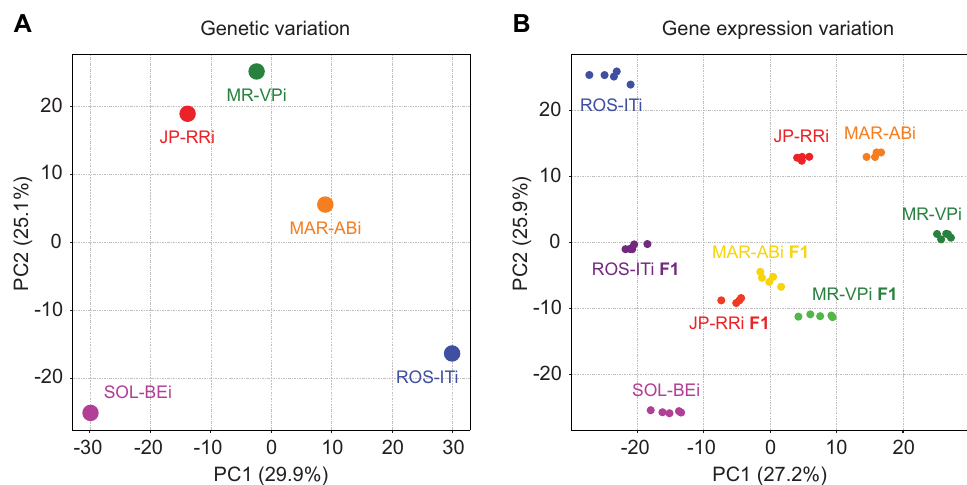
Fig 1. Genetic and gene expression relatedness among five inbred T . urticae strains. (A) A principal component (PC) analysis based on genetic variation (SNPs) shows relatedness among the five strains, as indicated by points with attending inbred strain names. (B) A PC analysis based on transcriptome profiles shows the similarities among the five strains and the F1 hybrids developed from crosses of four strains (ROS-ITi, JP-RRi, MAR-ABi, and MR-VPi) to a common parent (SOL-BEi). For F1 samples, labeling is based on the parent that varies (i.e., the non-SOL-BEi parent). Transcriptome data was collected from 4–7 day-old adult females, and each dot represents a biological replicate (4–5 replicates were used for each genotype). For both panels, PC1 and PC2 are indicated on the x- and y-axes, respectively (the percent of variance explained by each PC is given in